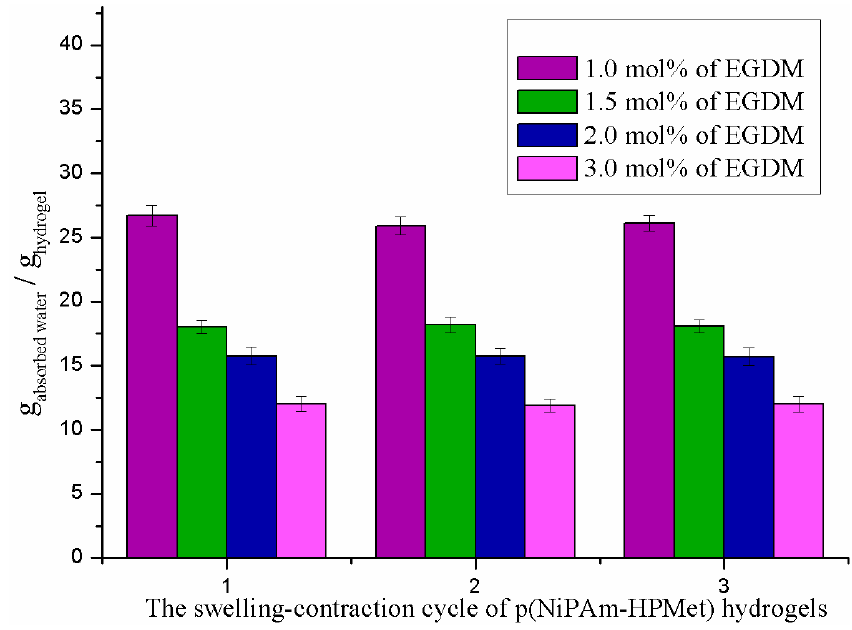
Figure 2. Swelling reversibility of p(NiPAm-HPMet) hydrogel at alternating swelling/contraction for three cycles under the temperature change from 10 °C to 50 °C. Error bars represent the standard deviation of the means of three replicates.